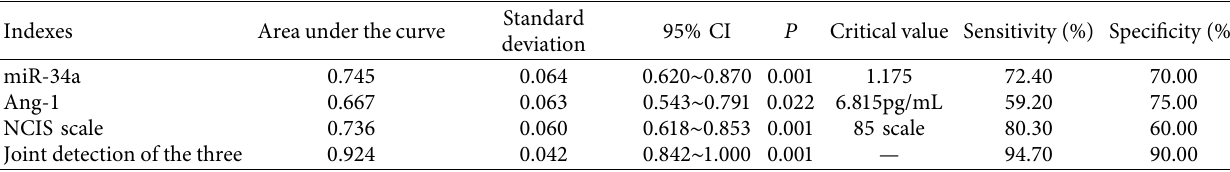
Table 1: Predictive value of serum miR-34a, Ang-1, and NCIS scores individually and their combined detection on death in children with